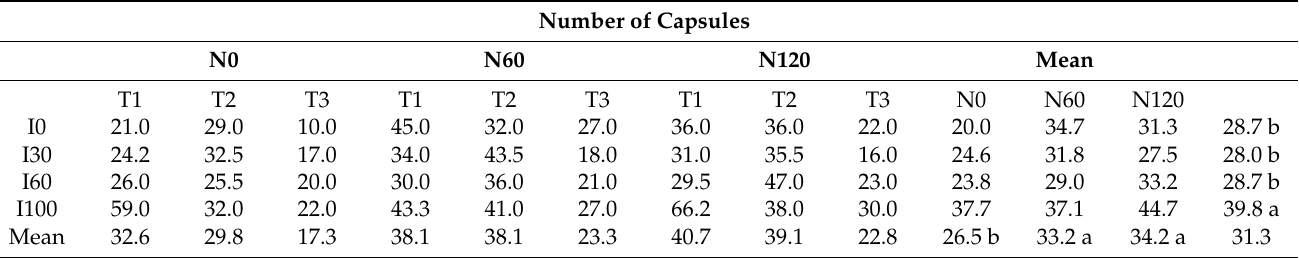
Table 2. Number of capsules in relation to irrigation (I0, I30, I60, and I00 = 0, 30, 60, and 100% ETm, respectively) and N level (N0, N60, and N120 = 0, 60, and 120 kg ha − 1 N) of primary and secondary racemes in 2021 and secondary racemes in 2022 (T1, T2, and T3). In the mean columns, the average values of all N levels (last row) and the average values of all irrigation levels (last column) followed by the same letter did not significantly differ at p ≤ 0.05. Number of Capsules